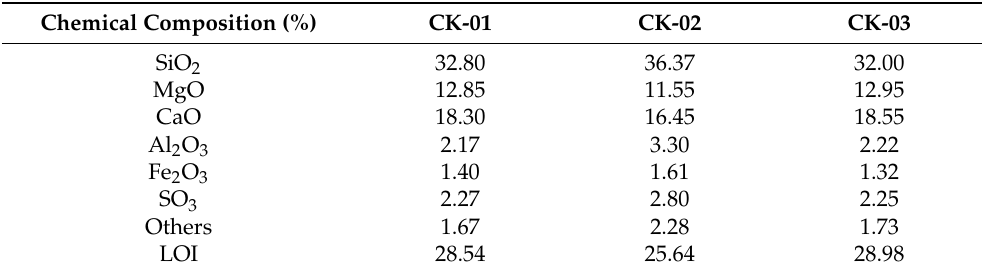
Table 2. Chemical composition of the